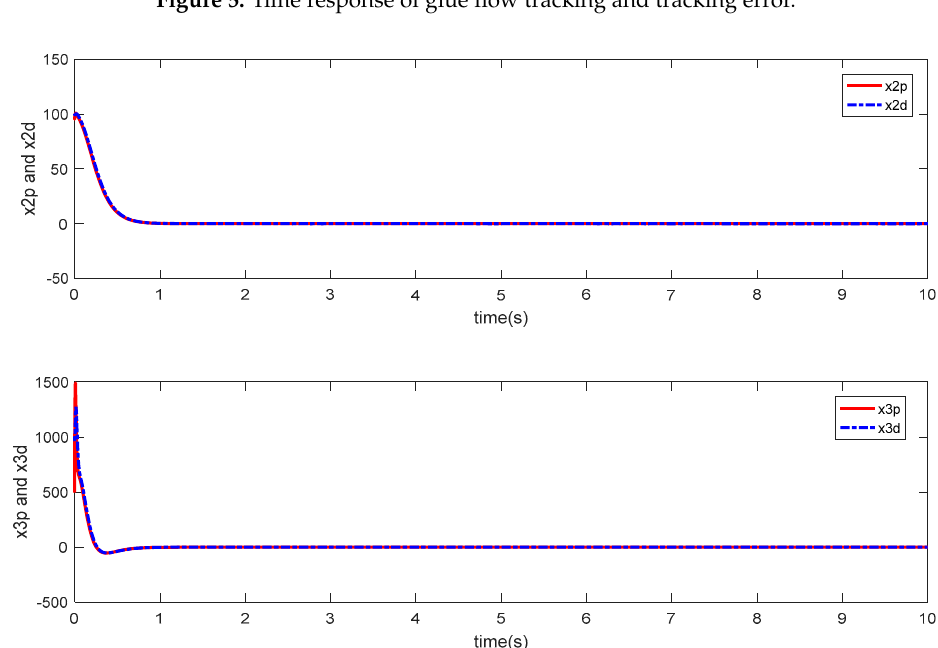
Figure 6. Time response of the first-order low-pass filter. ×2p and ×3p represent the input of the first-order low-pass filter x 2 and x 3 , respectively; ×2d and ×3d represent the output of the first-order low-pass filter x 2 d and x 3 d , respectively.